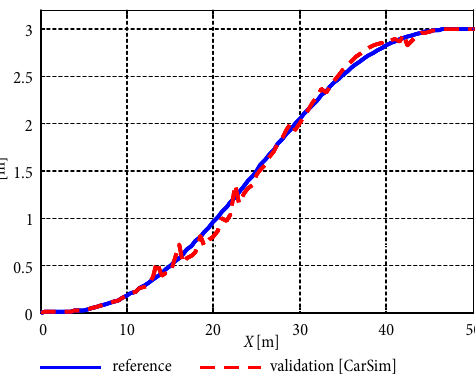
Fig. 16. Validation of controller compared with the reference path (lane-change case)